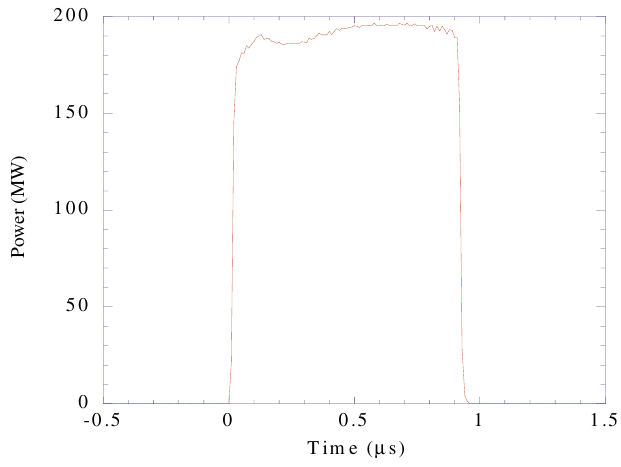
FIG. 28. (Color) System response after low-level rf correction is applied. (a) Power levels and (b) close-up view for the phase of the output